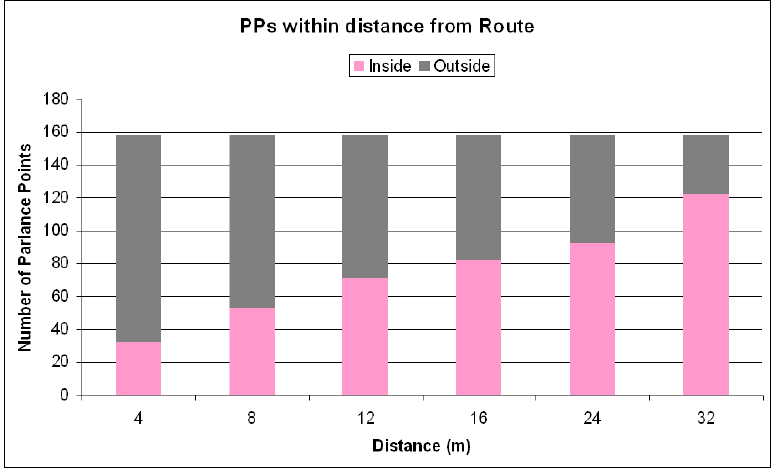
Figure 8. Distance relation between PP location and predefined